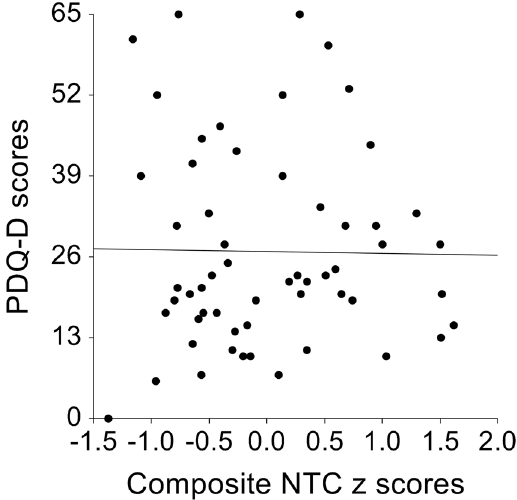
Figure 1. Correlation between composite z scores of four neurocognitive tests and perceived deficits questionnaire for depression scores (Pearson’s correlation coefficient r = − 0.02, p = 0.91).